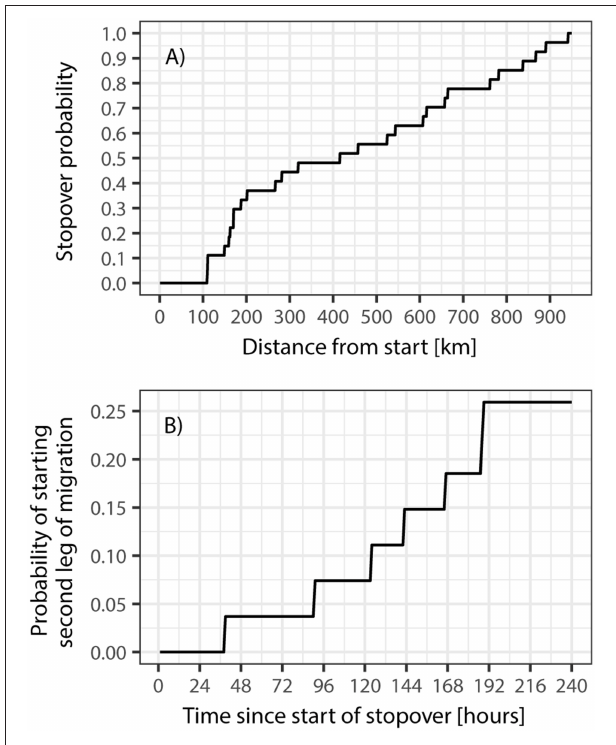
FIGURE 3 | Stopover probability over time for mallards on spring migration from the Lake Constance region (A) and probability of starting a second leg of migration as a function of time since arriving at the stopover (B) . Note that the y-axis of the latter does not reach 1 due to the very long stopover times for most mallards (exceeding 240h). Furthermore, it should be noted that not every individual will embark on a second, or even third, leg of